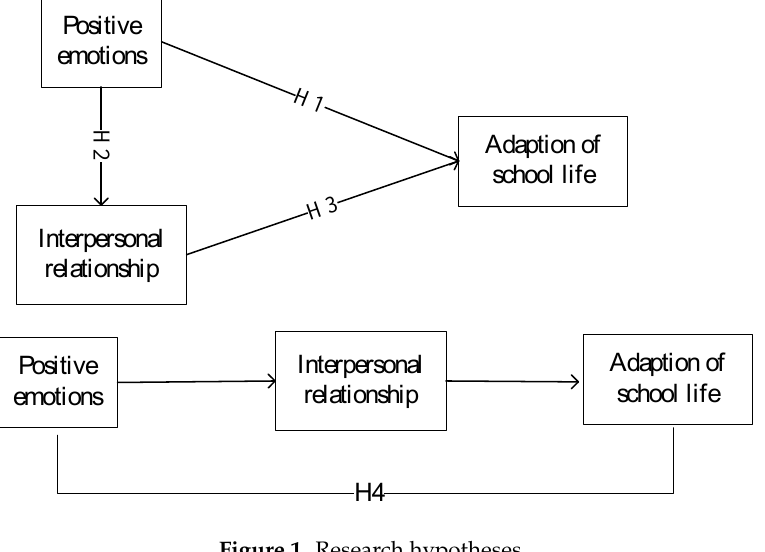
Figure 1. Research hypotheses.